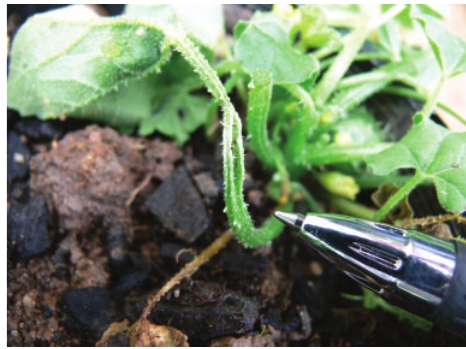
Figure 8: Section of plant stem ruptured during microwave treat- ment using the small aperture